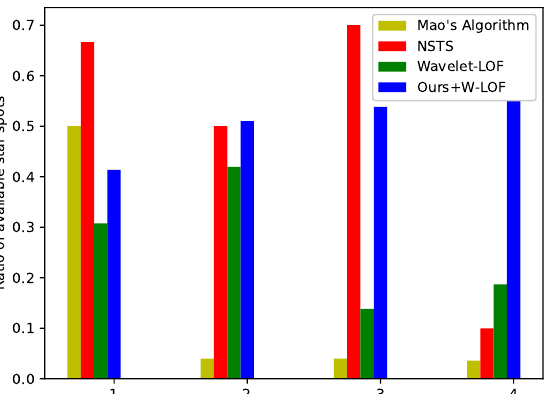
Figure 12. Comparison of the ratio of available star spots. One to four are star images in Figure 11 (1–4).